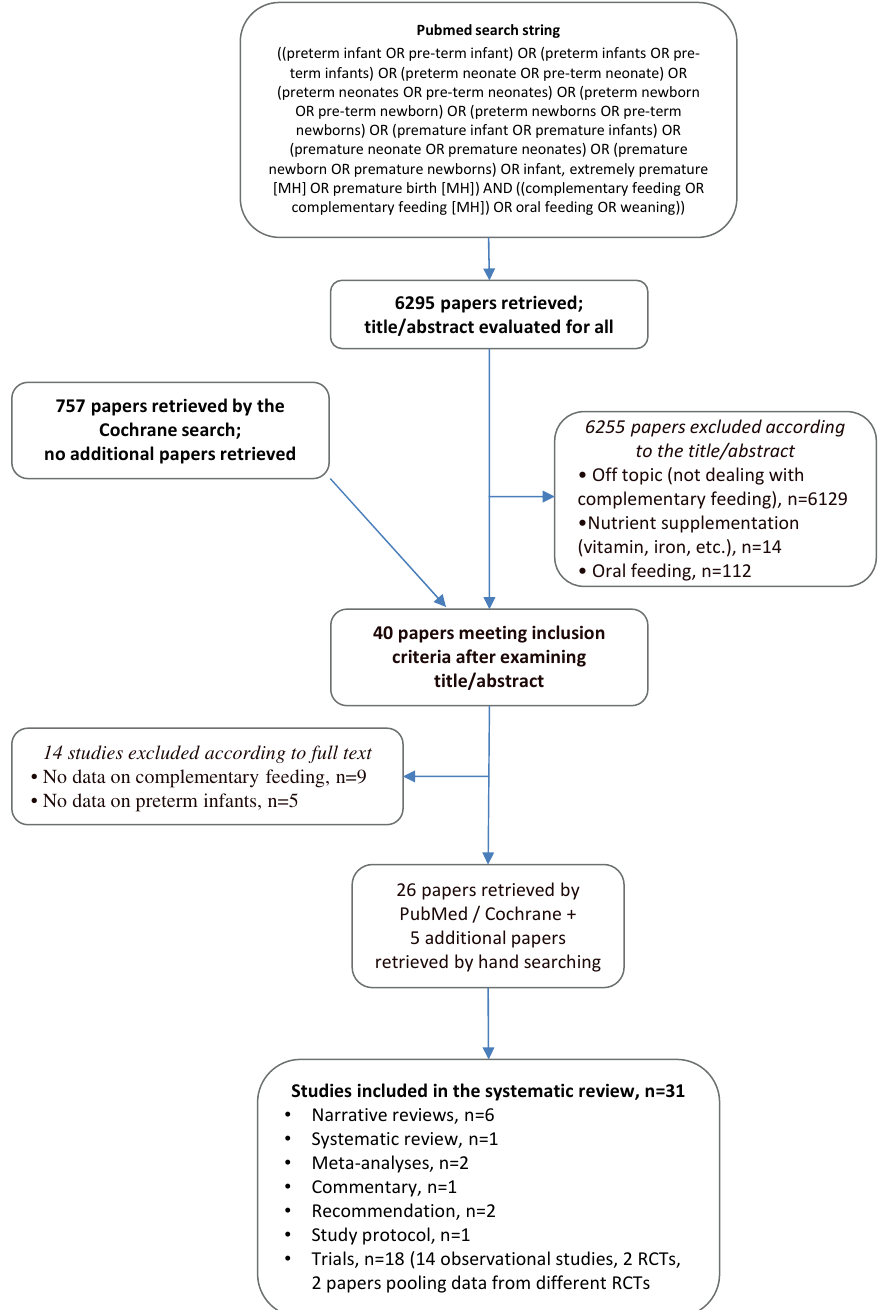
Figure 1. Search string and flow chart depicting the search strategy with relevant included and excluded studies. Reasons for study exclusion are also